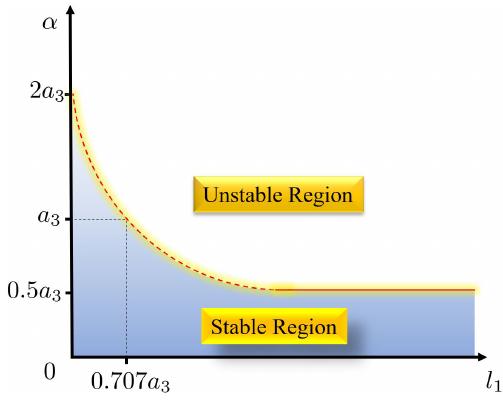
Figure 4. Stability boundary for values of α and l .